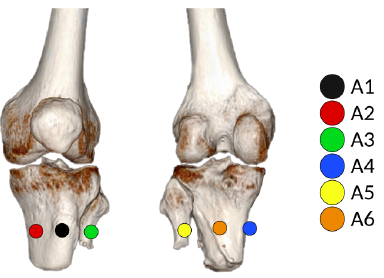
Figure 18. Location of sensors in the CROIs on the left residual limb.